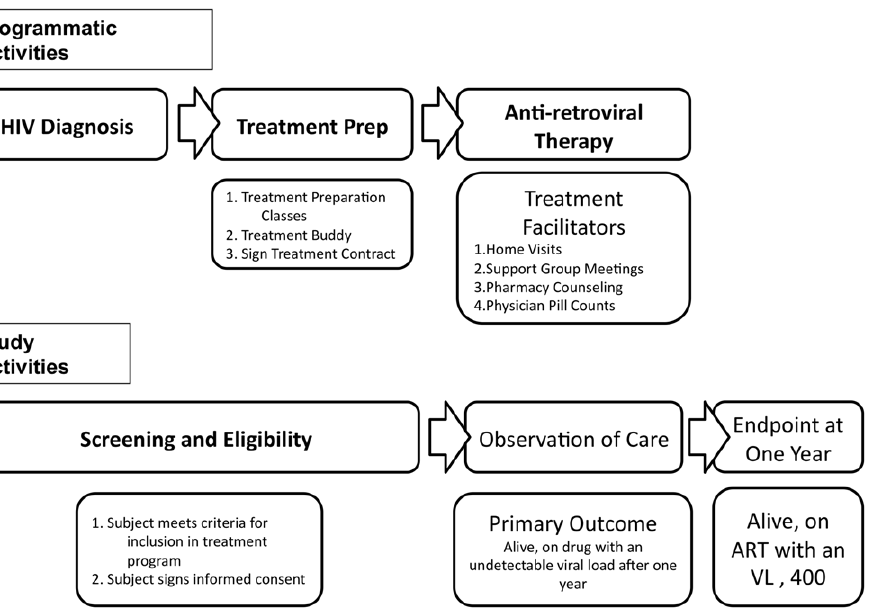
Figure 1. Schematic Diagram of HIV Program and Observational Study Design. The HIV program is divided into 3 distinct activities, HIV testing, Treatment Preparation, and Antiretroviral treatment that includes both community and clinic based facilitators. For entry into the study, subjects must be HIV positive and complete all treatment preparation activities. The study period begins with initiation of ART and evaluates the effects of treatment facilitators on treatment success. doi:10.1371/journal.pone.0032727.g001 PLoS ONE |